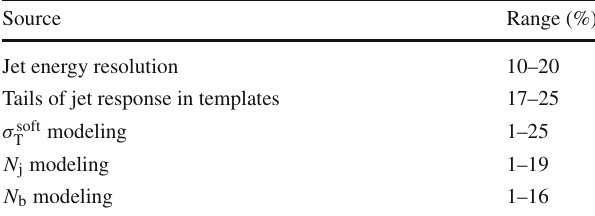
Table 4 Summary of systematic uncertainties in the multijet back- ground prediction, together with their typical size ranges across the